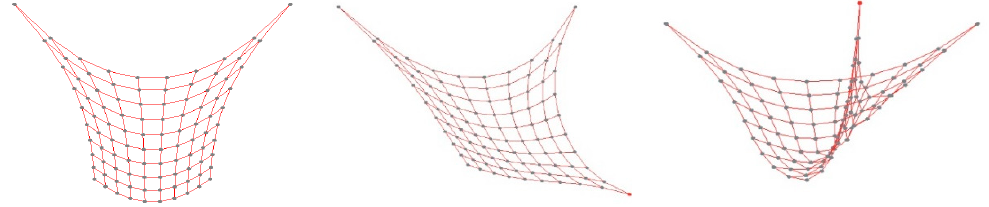
Figure 1. Cloth-like structure as a mass–spring system in an interactive simulation [7].